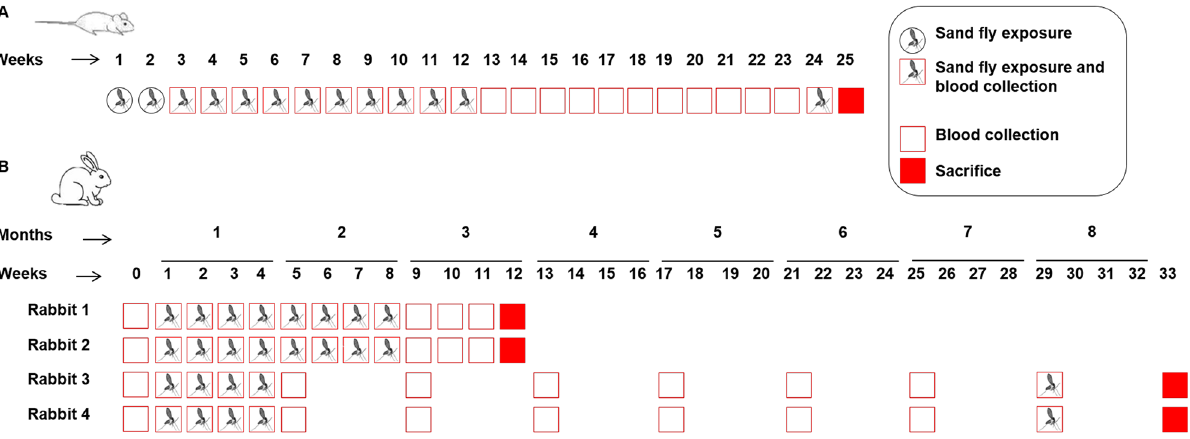
Fig 1. Immunization schedule. (A) BALB/c mice were experimentally exposed to the bites of 150 P . perniciosus during twelve weeks and followed during another twelve weeks. A new sand fly exposure was carried out at week 24 to evaluate a B cell recall. (B) Rabbits were exposed to 500 P . perniciosus bites for eight weeks and followed for a total period of twelve weeks (Rabbits 1 and 2) or exposed for four weeks and followed during seven more months (Rabbits 3 and 4). A new sand fly exposure was performed at week 29 and animals were bled the following week